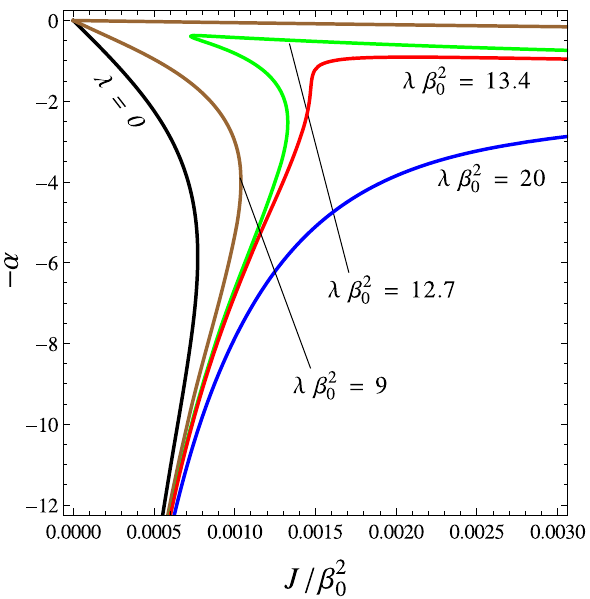
= 9 Fig. 11 Plots of β = const. curves on the ( h , k ) space for λβ 2 0 Fig. 10 Curves of the conjugate variable − α( J ) at fixed β in the = 12 . 7 (green), λβ 2 = 13 . 4 (red) and λβ 2 = 20 (brown), λβ 2 0 0 0 canonical approach. The λ = 0 (black) curve describes the standard = 9 (brown), λβ 2 = 12 . 7 (green), thermodynamic approach. The λβ 2 0 0 λβ 2 = 13 . 4 (red) and λβ 2 = 20 (blue) curves are the stability curves of 0 0 = 12 . 7 (green) curve has two turning points, the Rényi model. The λβ 2 0 = 9 (brown) exhibits two branches with while the stability curve of λβ 2 0 a single turning point in the lower branch